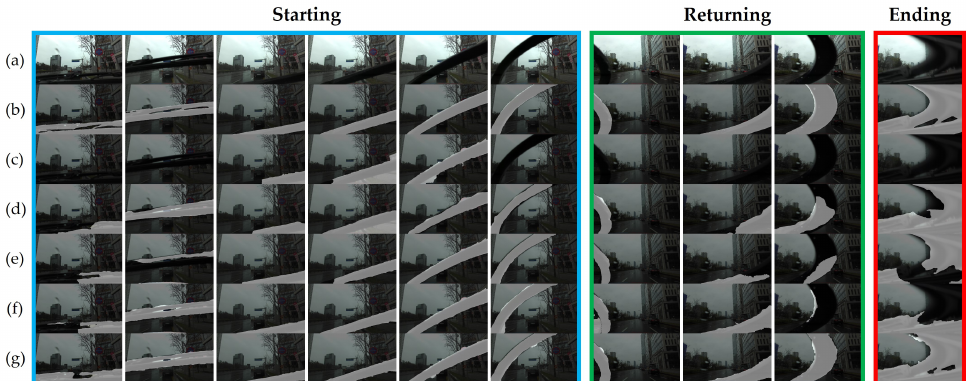
Figure 11. Qualitative results in terms of model: ( a ) original image; ( b ) ground truth wiper masks; wiper detection results by ( c ) raft-chairs; ( d ) raft-things; ( e ) raft-sintel; ( f ) raft-kitti; ( g ) proposed BTS. Our methods demonstrates significant improvement compared with the performance of pre-trained models of RAFT. Starting state (blue), returning state (green), and ending state (red) are categorized by bounding boxes. Best viewed with zoom-in.